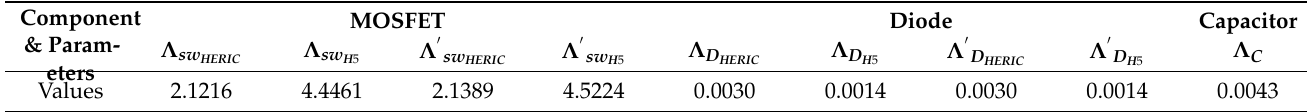
Table 7. Numerical Values for Components Failure Rates in HERIC, H5, and IFTPVI.